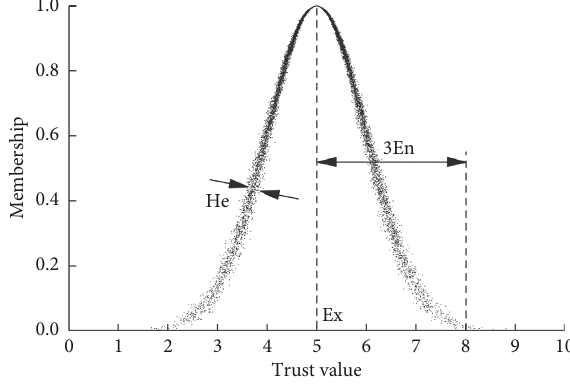
Figure 3: Diagram of the cloud